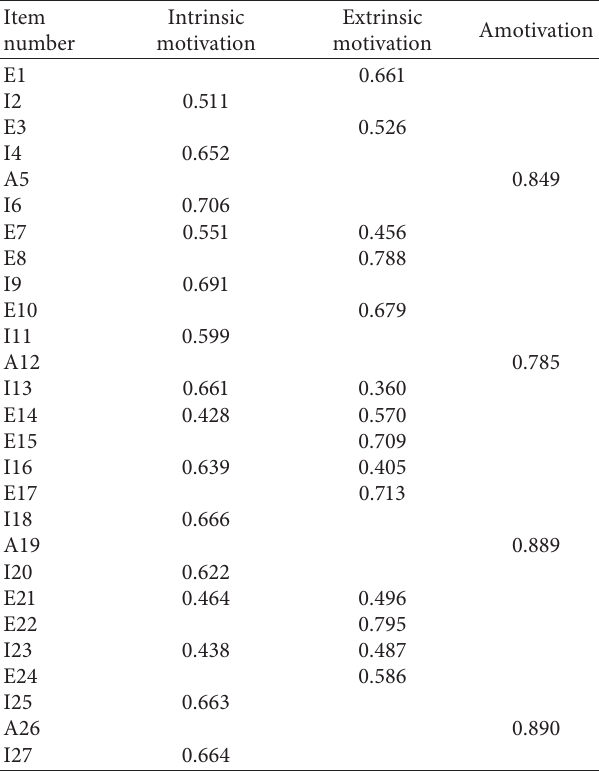
Table 4: AMS items loading.